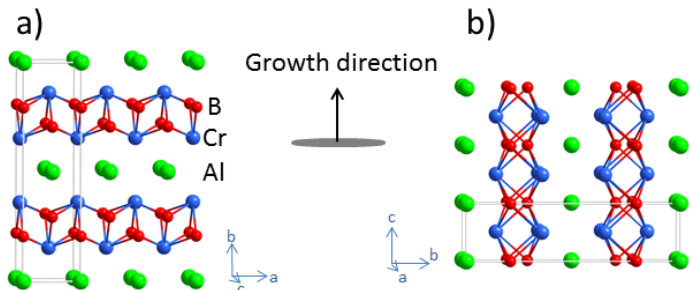
Figure 1. Crystal structure of Cr 2 AlB 2 showing the CrB slabs separated by Al layers. Sputtering of a thin film with an [010] orientation will expose Al layers to the plasma ( a ) while a film growing with